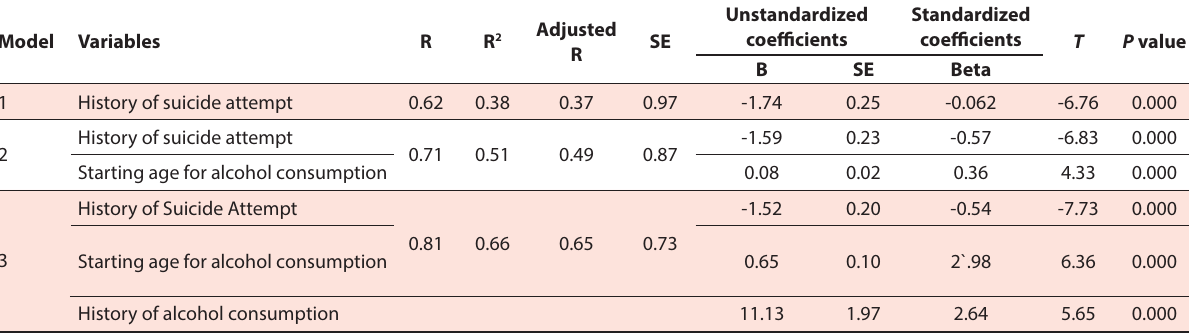
Table 4. Results of regression test and models and standardized beta coefficients for predicting suicide attempt (criterion variable: suicide attempt) Model